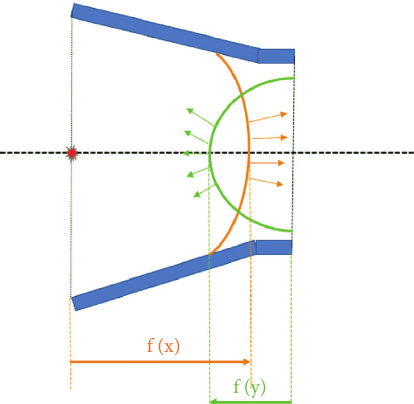
Figure 8: Schematic diagram of axial sparse waves at the deto- nation and nondetonation